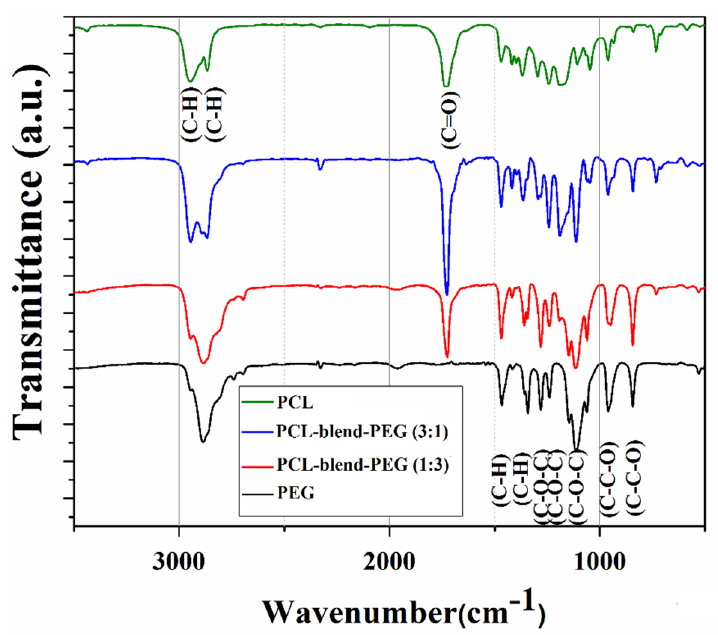
Figure 3. Typical FTIR spectra of dip-coated polymer films with polycaprolactone (PCL) (green); polyethylene glycol blends (PEG) (black); polycaprolactone-polyethylene glycol blends (PCL-blend-PEG) (1:3) (red); PCL-blend-PEG (3:1) (blue).